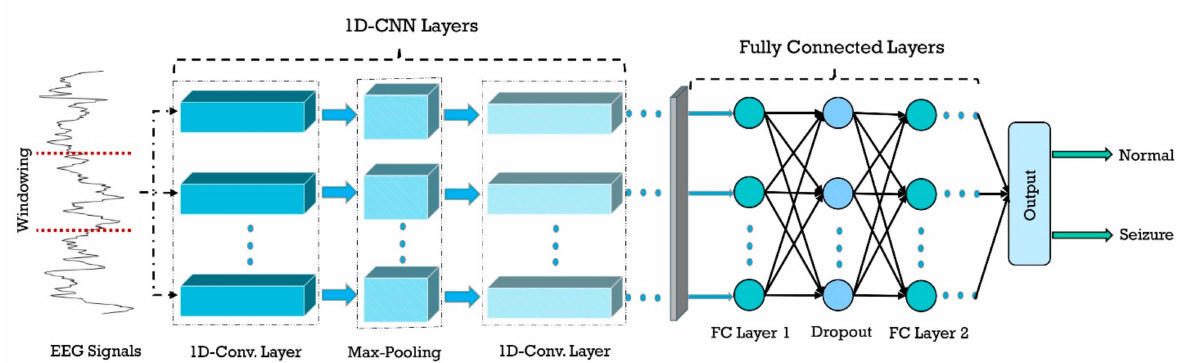
Figure 8. Typical sketch of the 1D-CNN model that can be used for epileptic seizure detection.